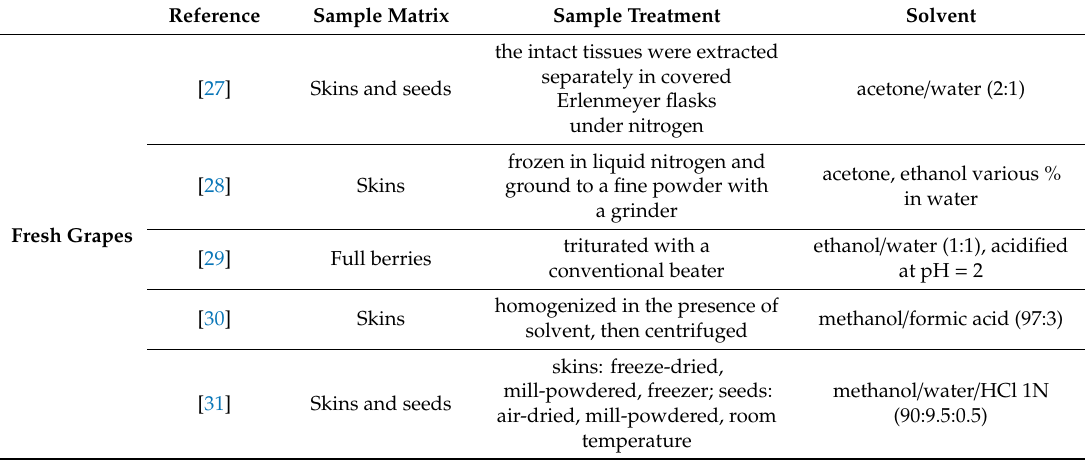
Table 1. Short description of the main extraction methods of polyphenols reported in the